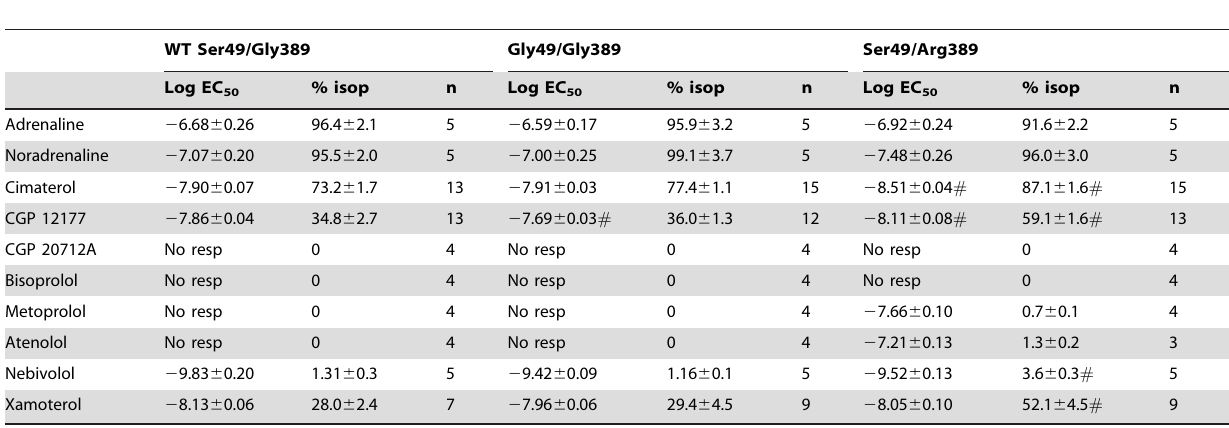
Table 2. Agonist responses at the wildtype and polymorphic variants of the b 1-adrenoceptor.